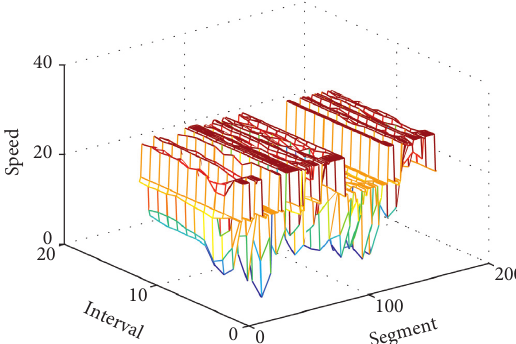
Figure 14: The optimal averaged